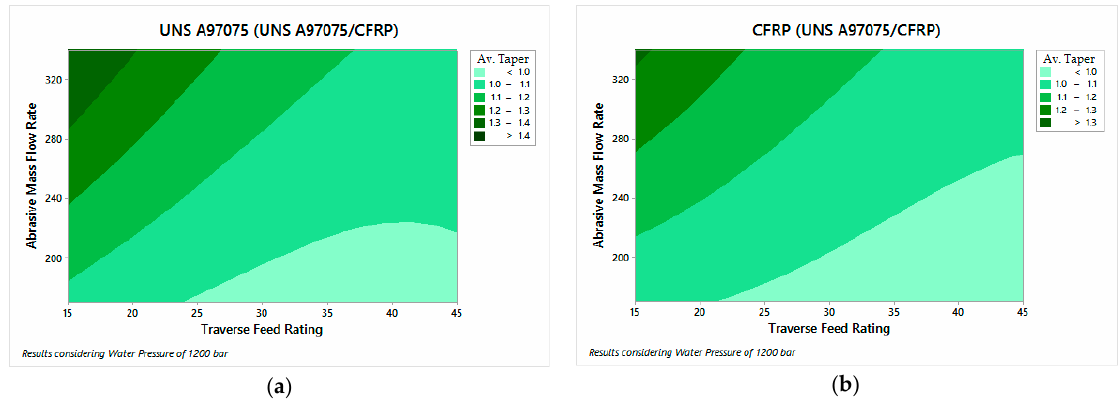
Figure 10. Average kerf taper for USN A97075/CFRP configuration: ( a ) UNS A97075; ( b ) CFRP .